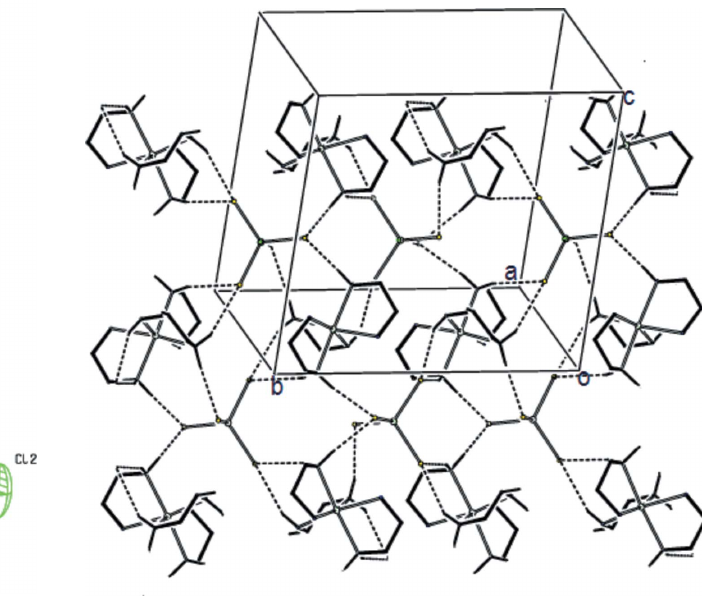
Figure 2 The crystal packing of title complex, viewed approximately down the a axis, with hydrogen bonds (Table 1) shown as dashed lines.